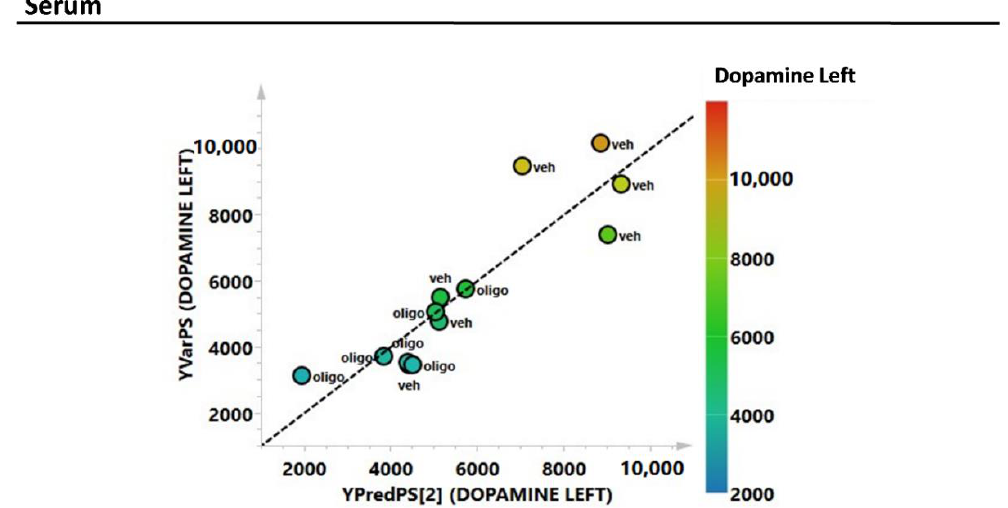
Figure 7. PLS correlation analysis of the complete metabolic profile of the serum samples with the level